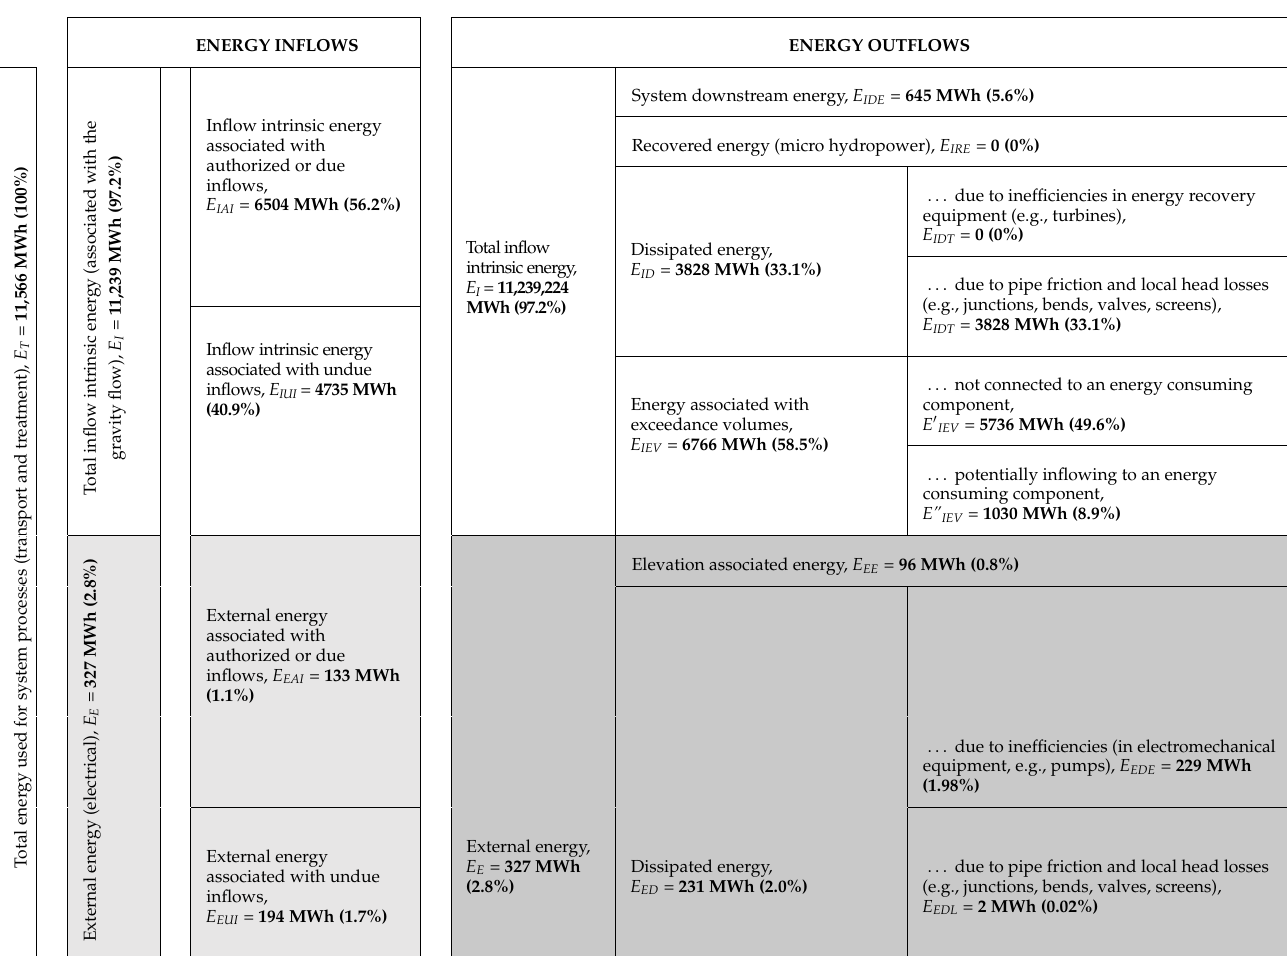
Table A2. Results of the energy balance application in January: wet season (MWh, % of the total energy used for system